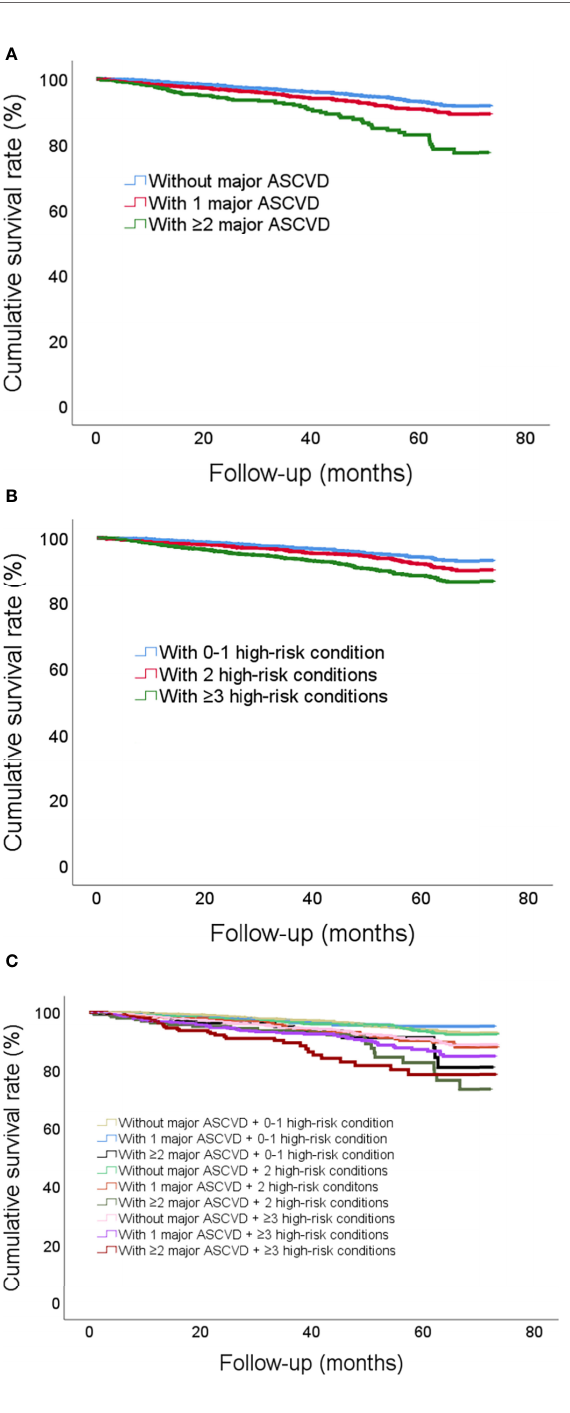
FIGURE 3 | Cumulative incidence curves illustrating the risk offuture recurrent events according to (A) number of mASCVD events, (B) number of high-risk conditions, and (C) combinations with number of mASCVD events and high-risk conditions. MASCVD, major atherosclerotic cardiovascular disease.